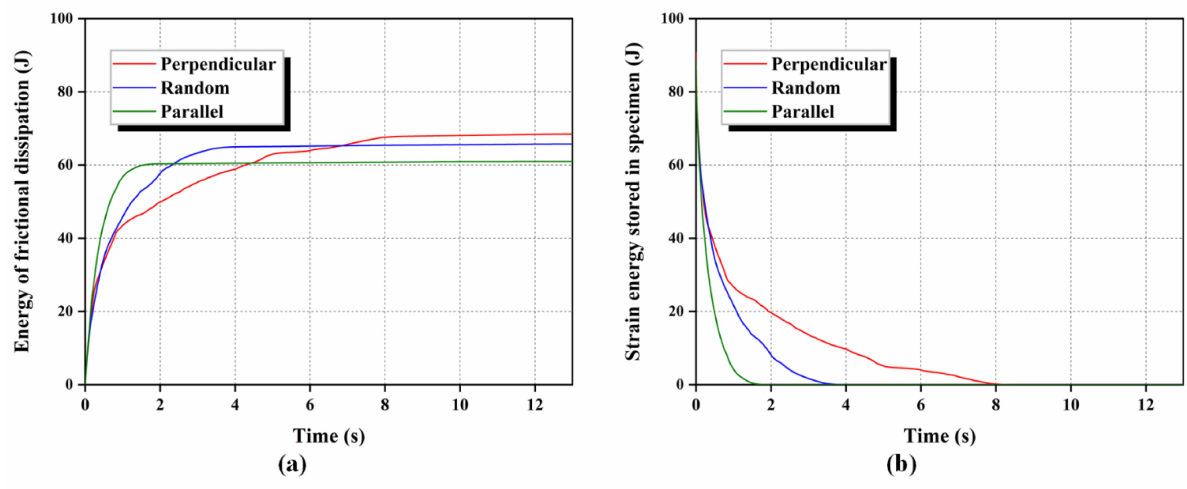
Figure 19. Evolution of system energy with time: ( a ) accumulated dissipation of frictional energy, ( b ) dissipated strain